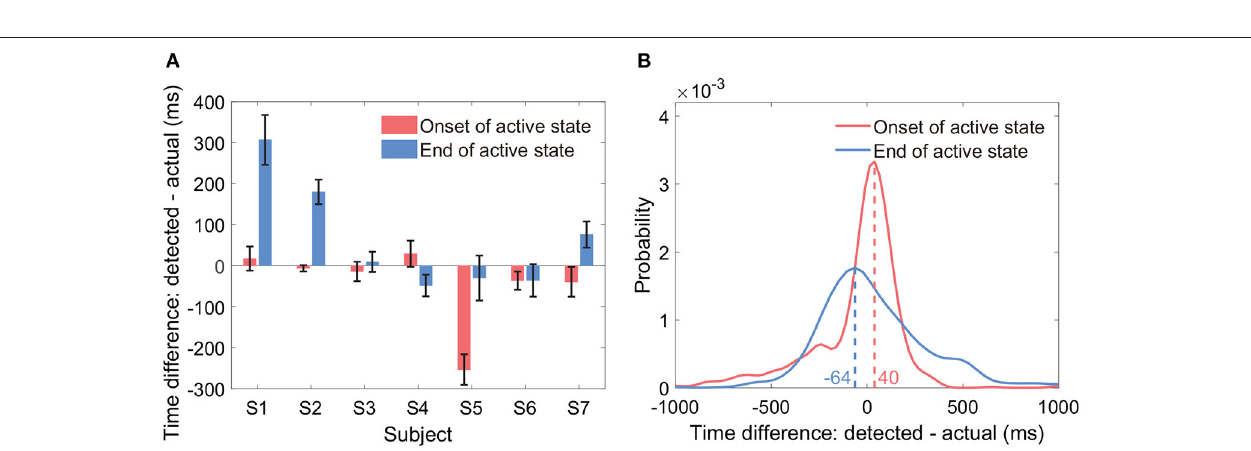
FIGURE 7 | Total accuracy and confusion matrix for each subject. The total accuracy of all periods of active and idle states for each subject is marked with red, and the chance level is marked with dark blue. In the confusion matrix, each row represents a type of actual state, and each column represents a type of detected state.